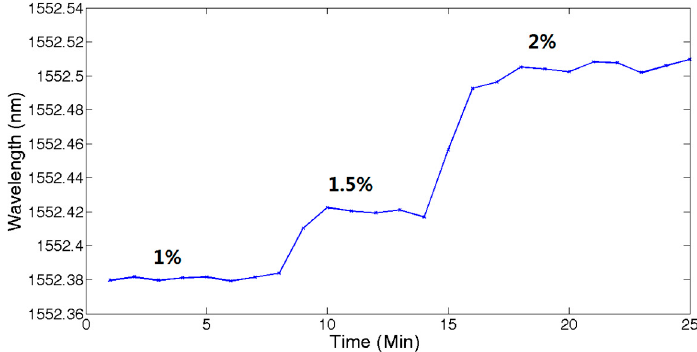
Figure 11. Hydrogen concentration measurement.